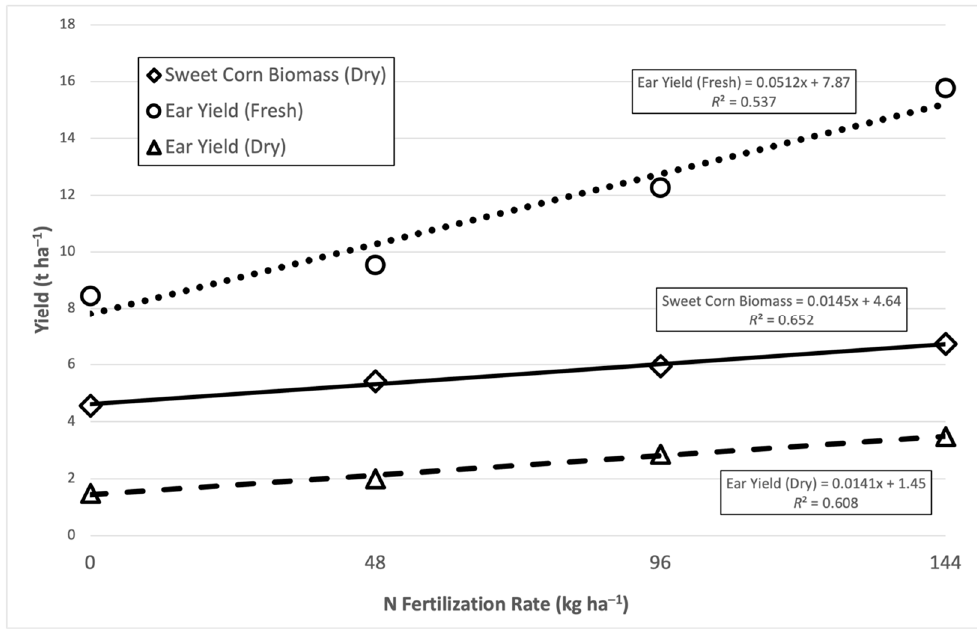
Figure 3. Mean dry sweet corn biomass and ear yield by weight as a function of N fertilization rate in 2020. Goodness of fit described with conditional R 2 .